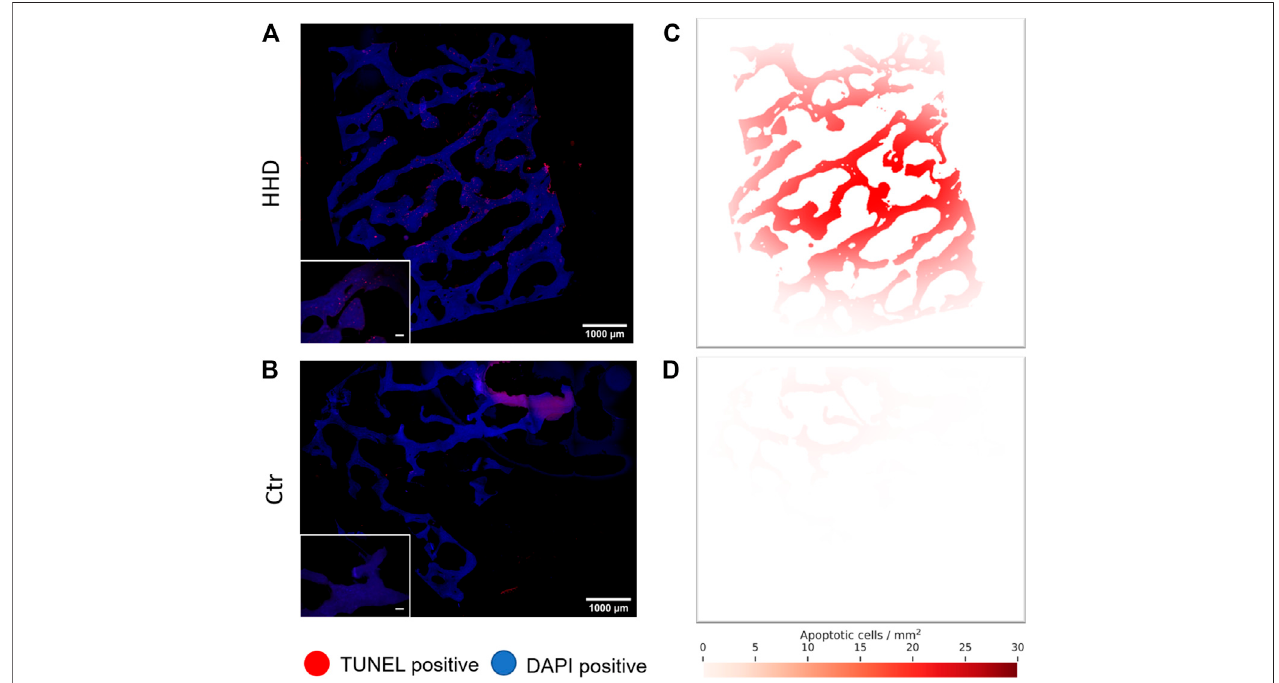
FIGURE 9 | Representative histological fl uorescence images of trabecular bone apoptosis, identi fi ed via TUNEL Assay. In (A) HHD treated sample (300 mPa 20 Min) and (B) in an untreated control. Imagesin the lower left represent magni fi ed sections of the whole sample image, scale bars in these images represent 100 μ m. Respective apoptoticcelldensity mapsofthesame (C) HHD treated sampleand (D) untreatedcontrolwerederivedfromthewholesampleimage.Allimagesstemfromasingledonor.